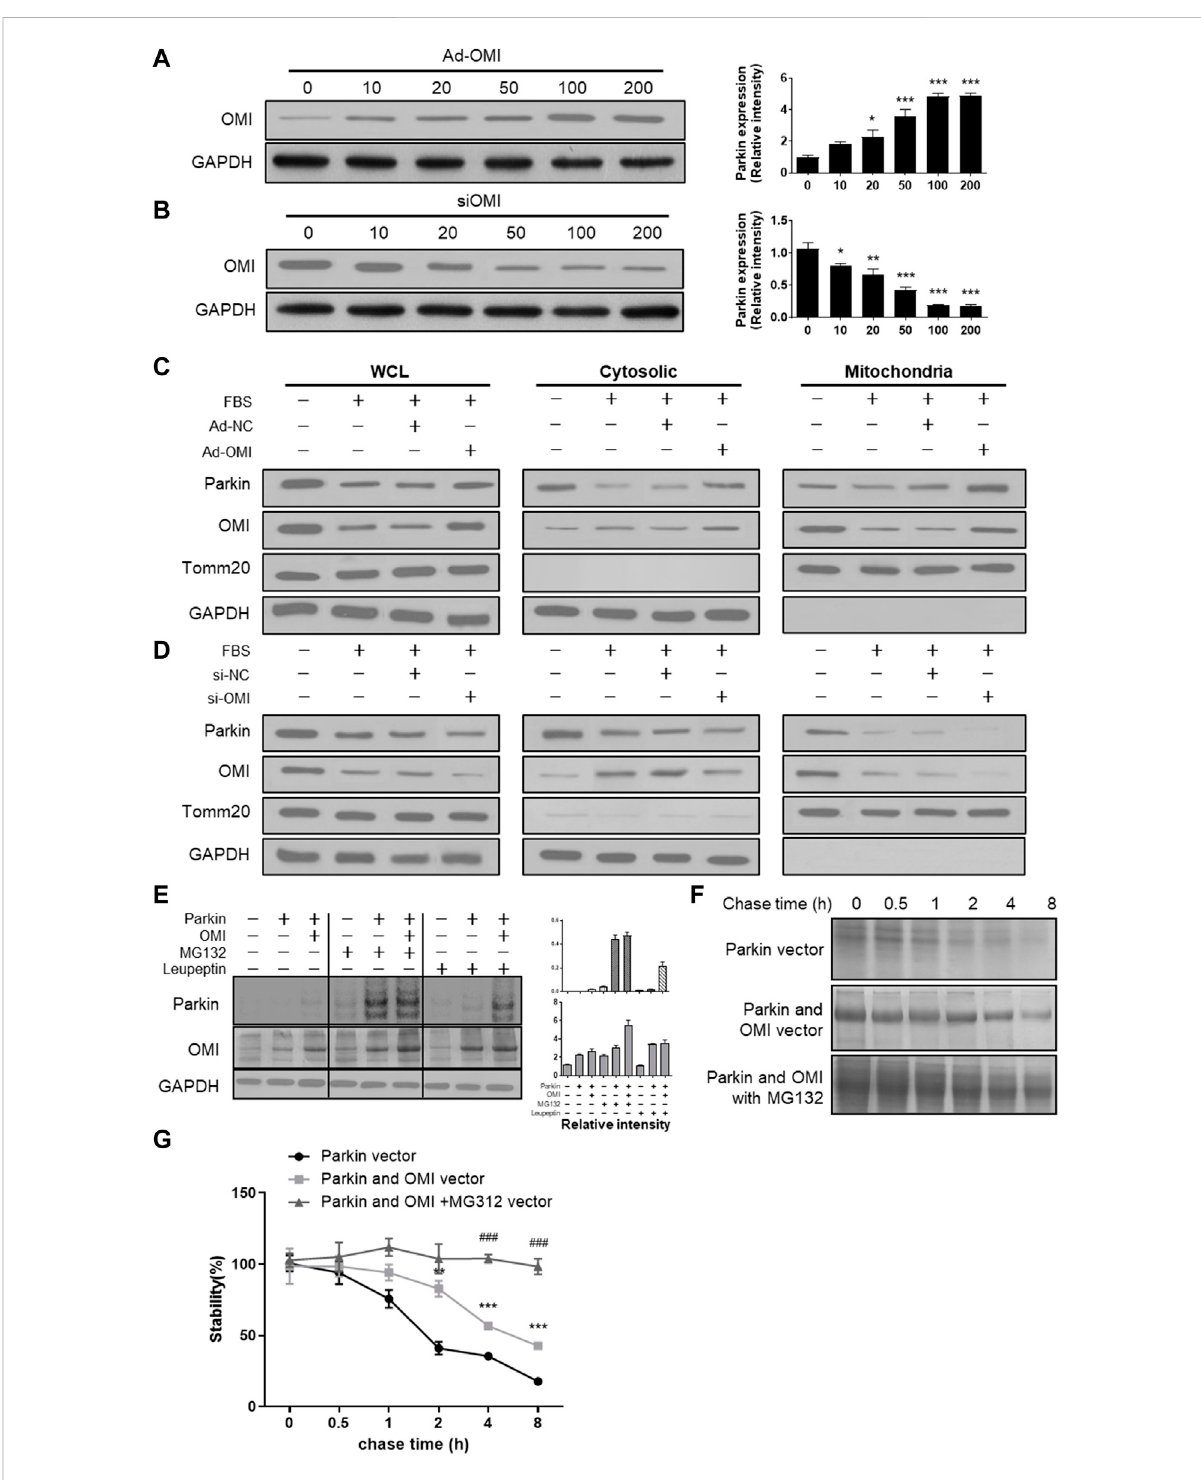
FIGURE 4 ER α -NRF1-OMI involved in regulating parkin expression. (A,B) Western blot analysis of OMI in A7r5 cells transfected with different OMI of adenoviruses (A) or siRNA (B) expressing OMI. (C,D) Western blot analysis of Parkin and OMI protein levels in total cell lysis (left), cytoplasm (middle) and mitochondria (right) of A7r5 cells treated with FBS, transfected with adenoviruses expressing OMI or noncoding control (C) and with adenovirusesexpressingOMIornoncodingcontrol (D) . (E) WesternblotanalysisofparkinandOMIproteinlevelsinHEK293cells.Thecellswere transfected with Parkin and OMI vector, and treated with MG132 and/or leupeptin. (F,G) Expression of OMI promoted Parkin stability via the proteasomal pathway. HEK293 Cells were transfected with Parkin alone [ (F) ; top panel], Parkin and OMI [ (F) ; middle panel], or Parkin and OMI with MG132 treatment [ (F) ; bottom panel], and levels of Parkin were detected by western blot analysis. The representative bolt (F) and quantitation of 3 independent experiments are shown (G) . * p < 0.05, ** p < 0.01 and *** p < 0.001 vs.